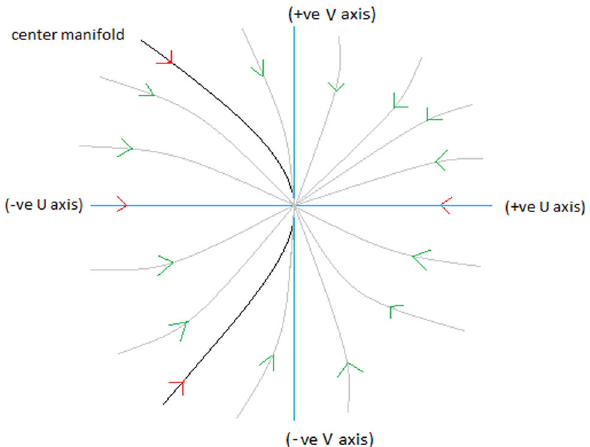
Fig. 1 Vector field near the origin for the critical point P 1 in UV -plane ( μ > 0)